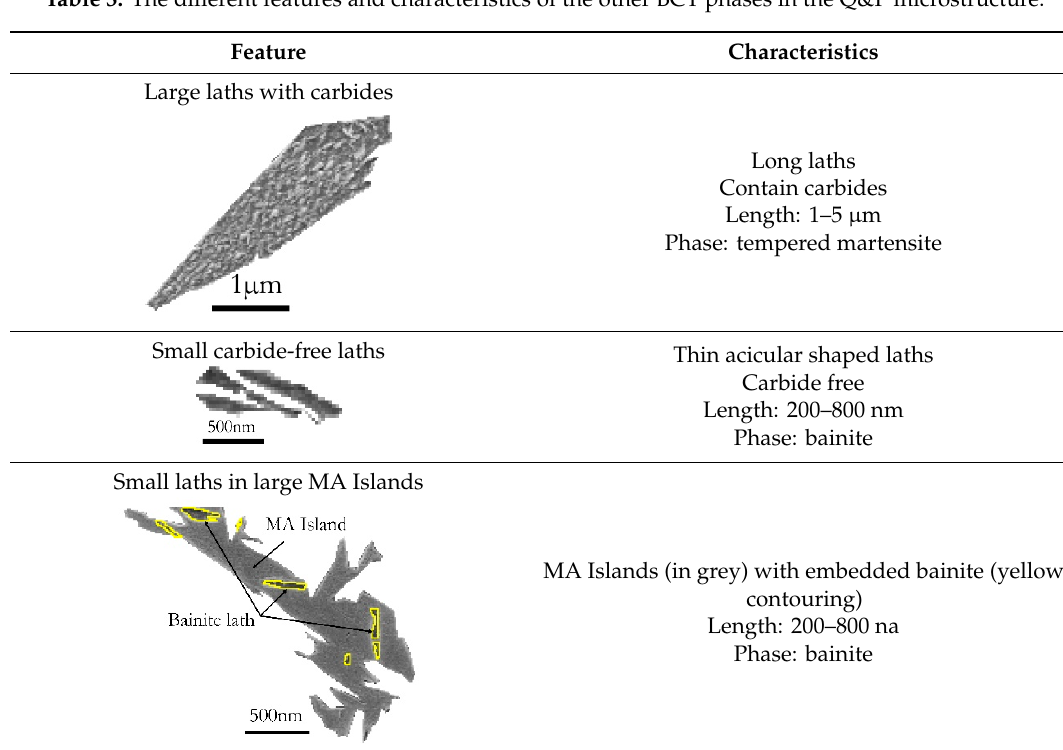
MA Islands (in grey) with embedded bainite (yellow